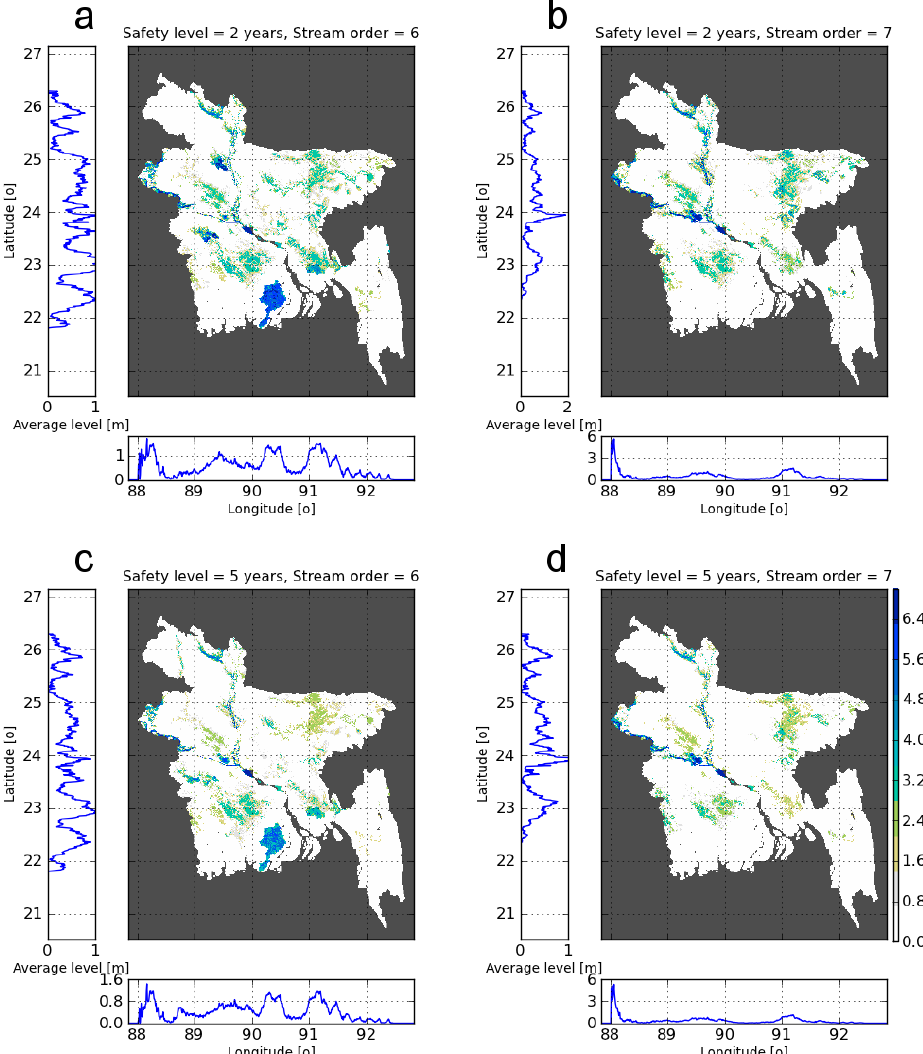
Fig. 7. The sensitivity of the downscaling to the 2 choices: (1) from which Strahler stream order do river floods occur?; and (2) at which minimum return period do floods start to cause damage? Each plot shows a top-view and zonal averages in longitudinal and latitudinal direction of inundation levels [m] at a 30yr return period. Each subfigure shows the results with different assumptions on the river size, and return periods at which river floods start to play a